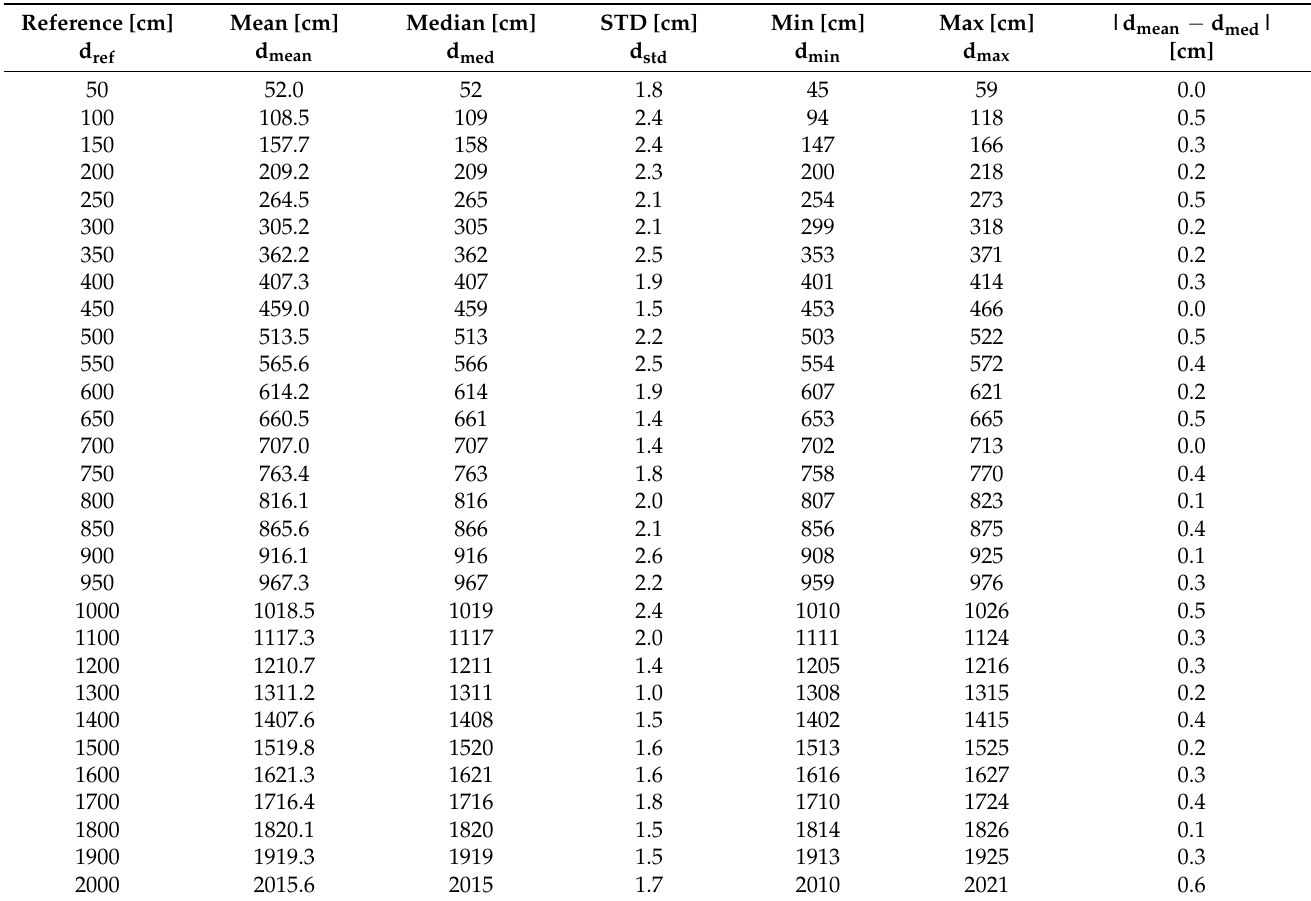
Table 2. Statistical measures of the distance under LOS